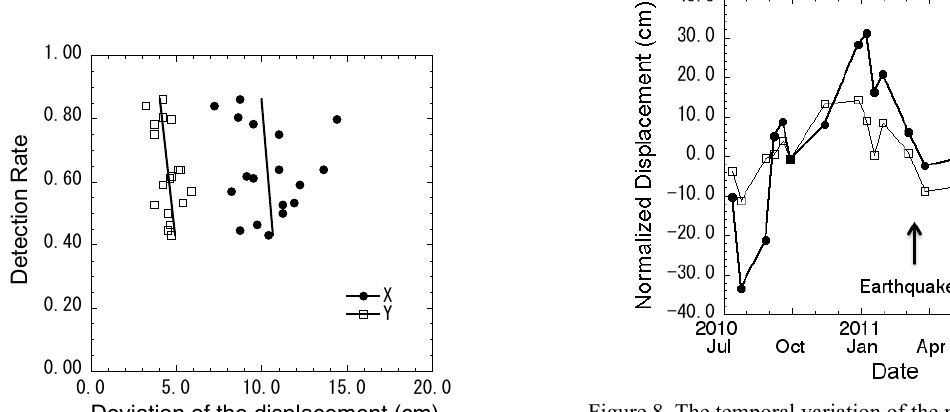
Figure 8. The temporal variation of the normalized average displacement of the study site when the slave image is